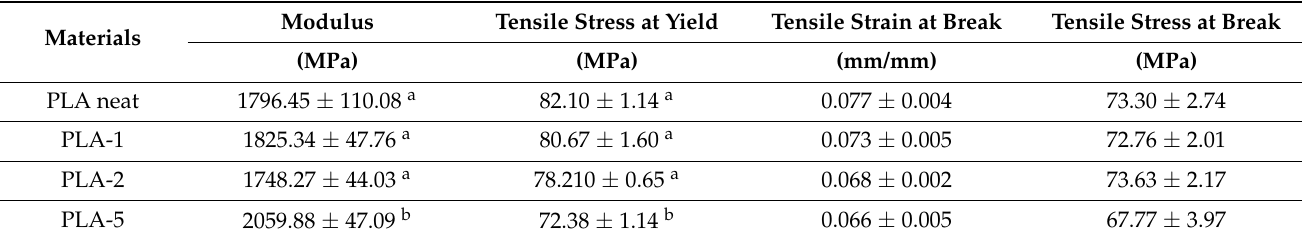
Figure 4. Modulus, tensile stress, and tensile strain graphs for PLA and blends. Table 5. Effect of MTPS content on tensile properties of PLA.